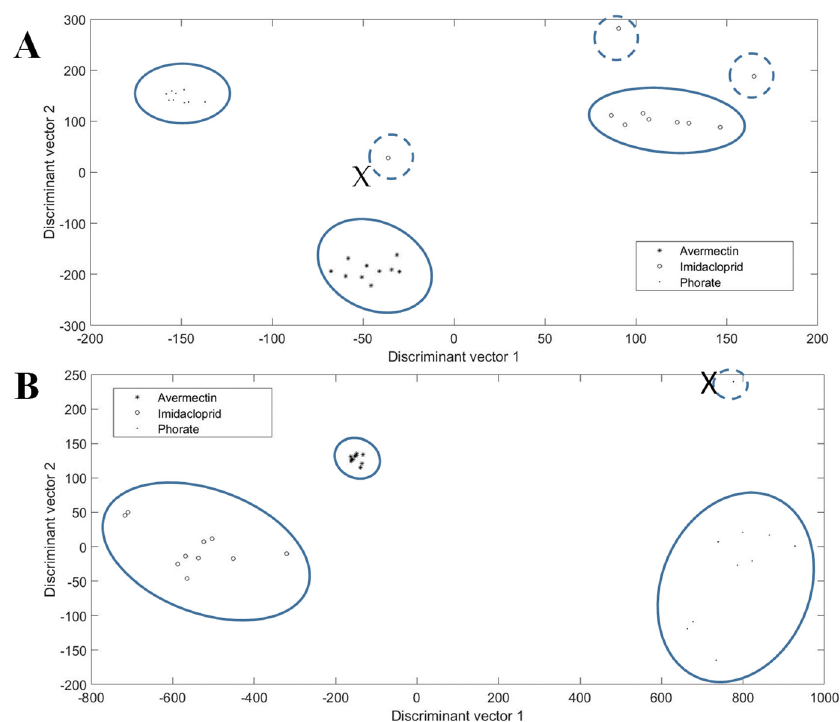
Figure5. Theclusteranalysisresultsofphorate(0.01mg / Kg), avermectin(0.01mg / Kg), andimidacloprid Figure 5. The cluster analysis results of phorate (0.01 mg/Kg), avermectin (0.01 mg/Kg), and (0.5 mg / Kg) sprayed on real-world samples of ( A ) lettuce and ( B ) imidacloprid (0.5 mg/Kg) sprayed on real-world samples of ( A ) lettuce and ( B ) rice.